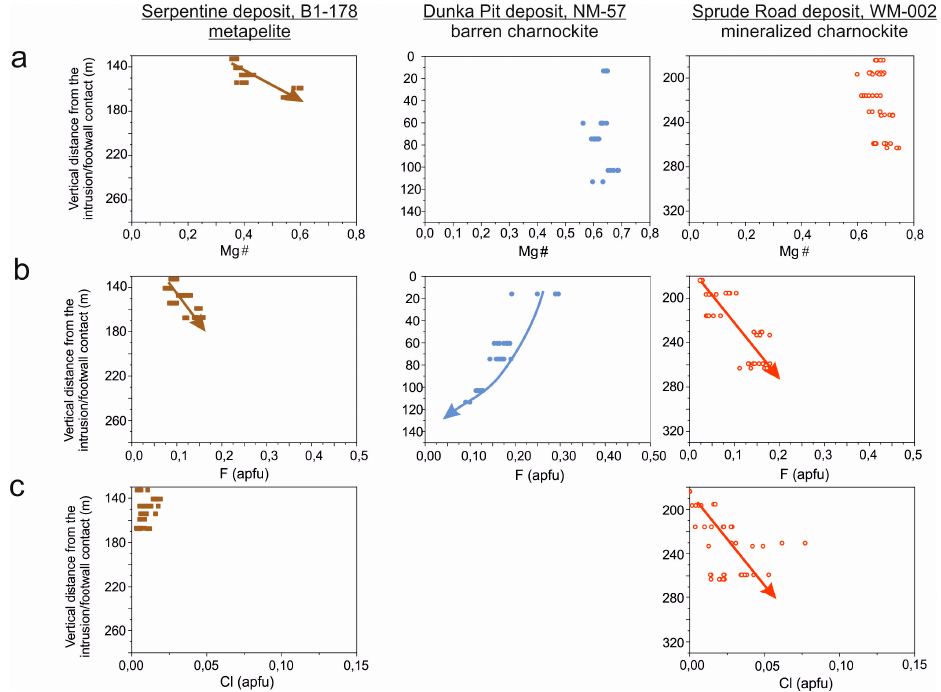
Figure 6. ( a ) Depth versus Mg# of biotite diagrams of the footwall of the studied drill cores. The top of the plots coincides with the intrusion-footwall contact. The Mg# in biotite is increasing with increasing depth in the B1-178 and WM-002 drill cores but does not vary in the barren NM-57 drill core. ( b ) Depth versus F (on the basis of apfu) diagrams of the studied drill cores. Fluorine content of biotite increased with increasing depth at the Serpentine and Spruce Road deposits but decreased at the Dunka Pit deposit. ( c ) Depth versus Cl (on the basis of apfu) in the analyzed biotite crystals. Note the significant increase of Cl content of biotite in the mineralized WM-002 drill core at the Spruce Road deposit. Cl content of biotite at the Dunka Pit deposit is below detection limit (0.1 wt. %) and is not presented in the figure.